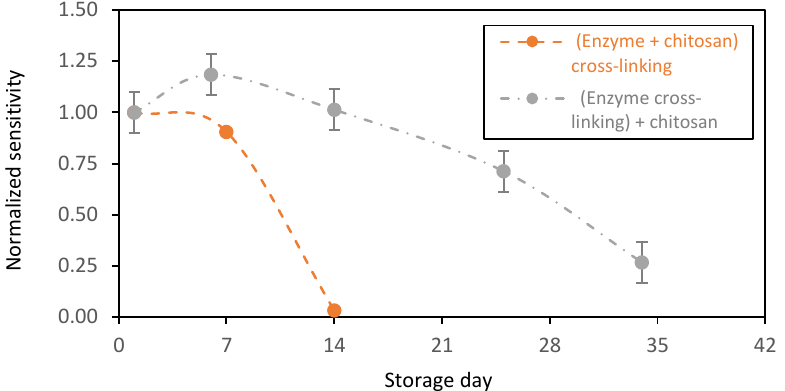
Figure 5. Stability in function of time of the chitosan-based biosensing membranes deposed on gold screen-printed electrodes and stored in PBS + glucose (2 mM) at 37 °C. Orange plot: GOx entrapped and crosslinked, and grey plot: GOx entrapped (average value and standard deviation on 2 sensors).